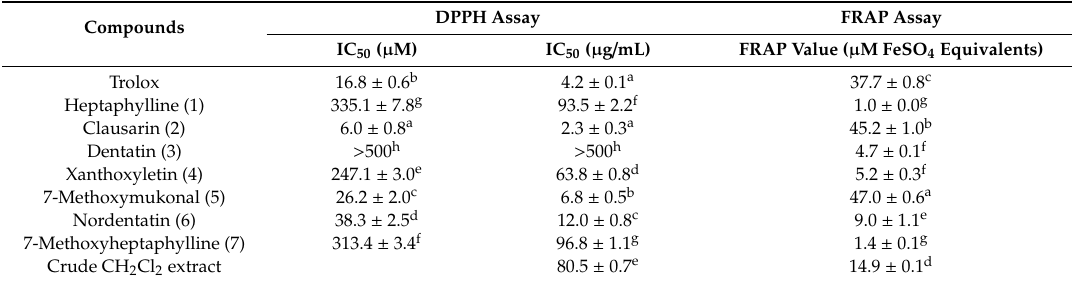
Table 1. Antioxidant capacities of isolated compounds and crude extract from C . harmandiana .